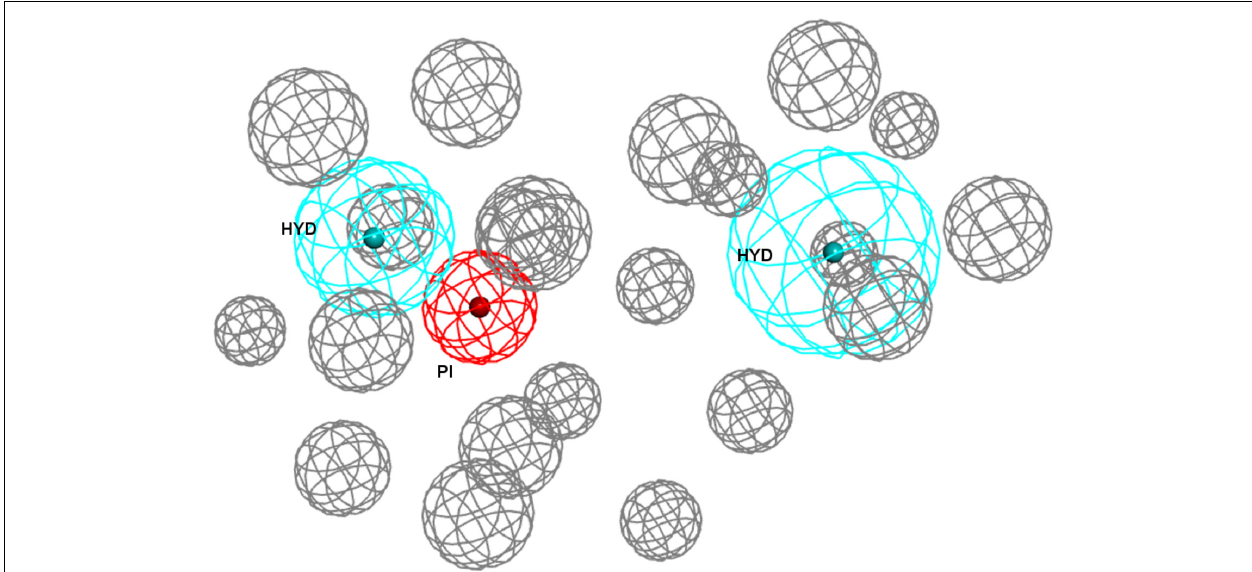
FIGURE 9 | 5HK1–Ph.B